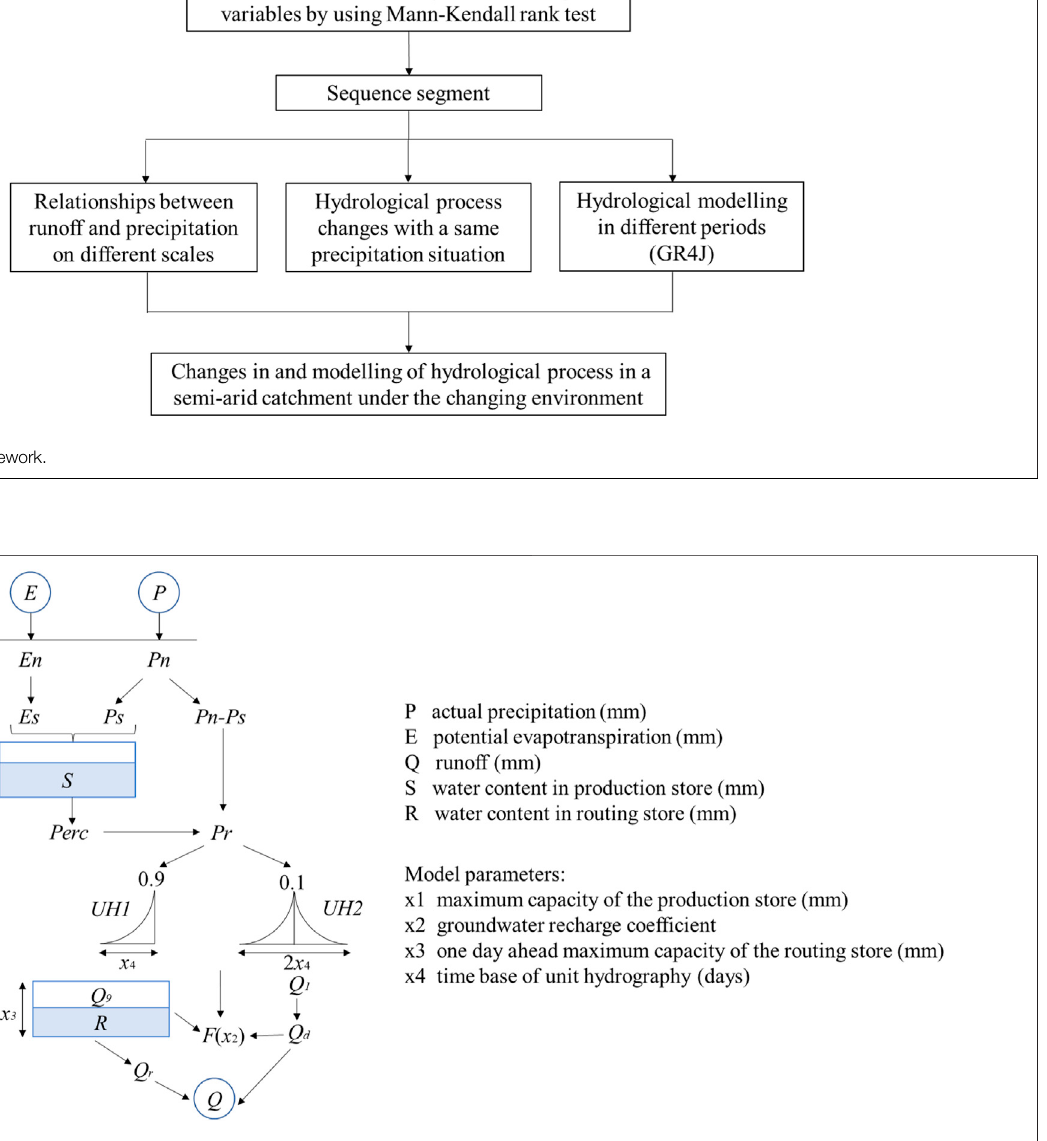
FIGURE 3 | Structure of the GR4J model (Oliveira et al., 1999).